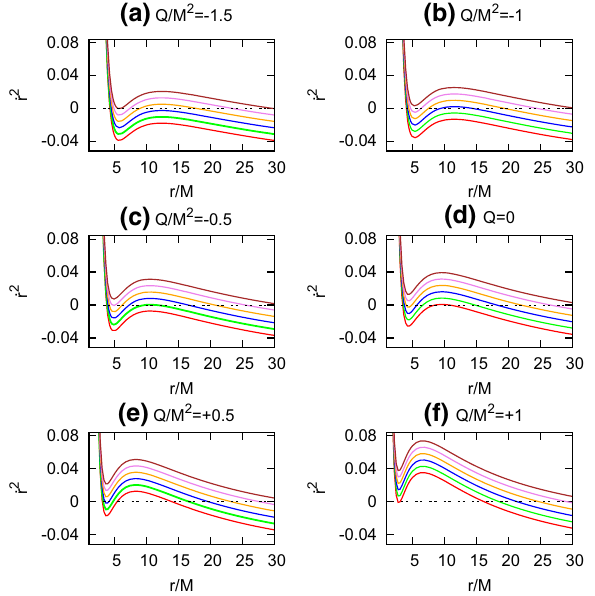
Fig. 5 ˙ r 2 as a function of r / M with l = ( l MBO + l ISCO )/ 2 and a fixed Q , where E varies from 0.955 to 0.975 from bottom to top